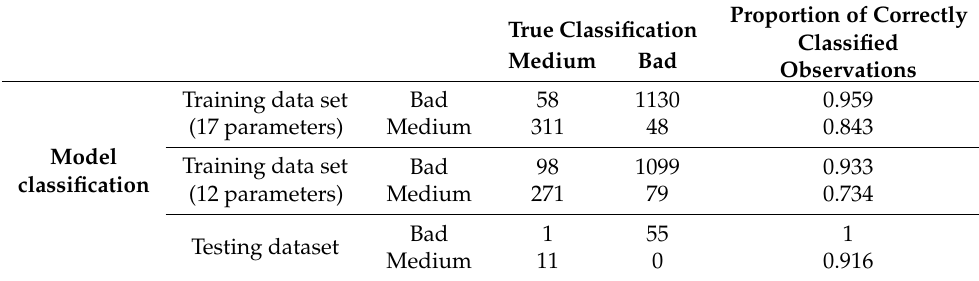
Table 5. Summary of the results achieved by the logistic regression